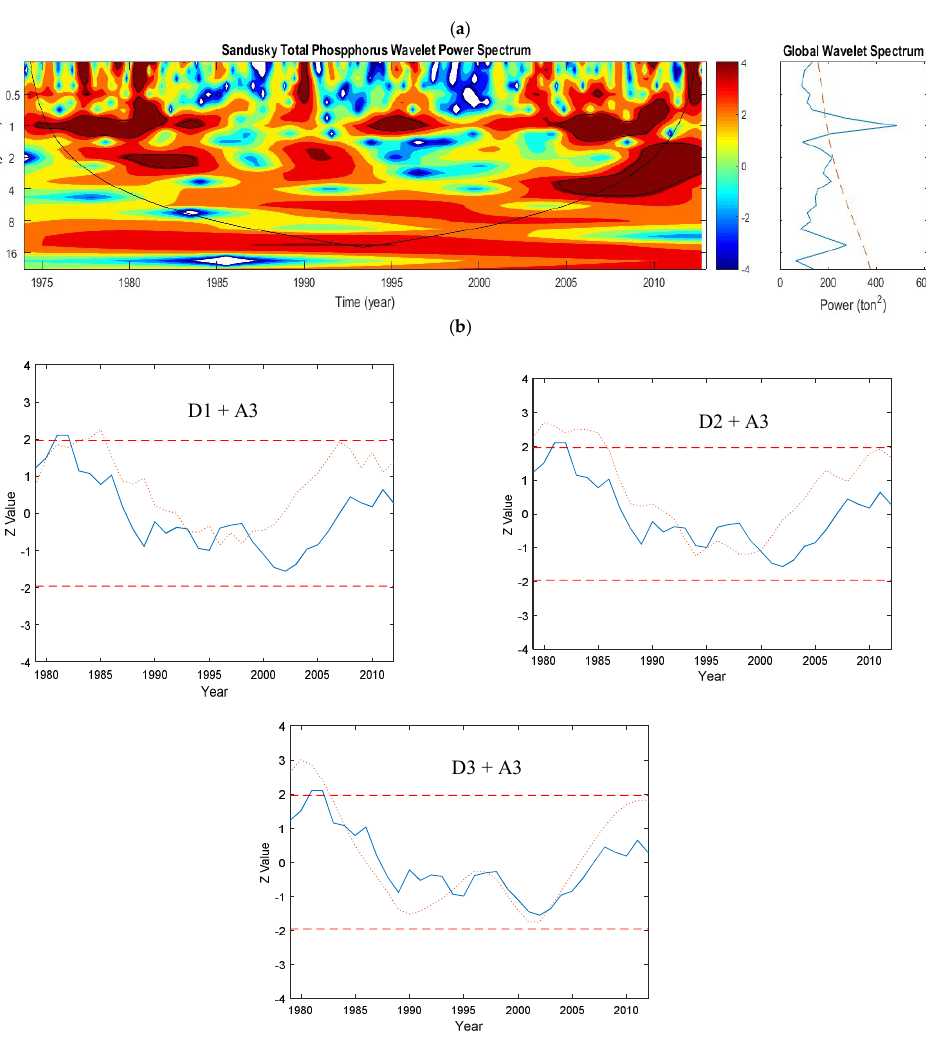
Figure 9. Sandusky River: ( a ) Wavelet power spectrum of the daily total phosphorus (TP). ( b ) Plots of the sequential Mann–Kendall analyses on the Details (with added Approximation component) of the annual TP data. The top and bottom dashed lines are ±1.96, which are the confidence limits of the MK test using α = 5%. The solid and dotted lines show the sequential MK values for the original data and the Detail components, respectively. For this TP data, until the early 2000s, the D3 (8 years) components was the most dominant periodicity for this trend. Hydrology 2018 , 5 , x FOR PEER REVIEW 16 of 28